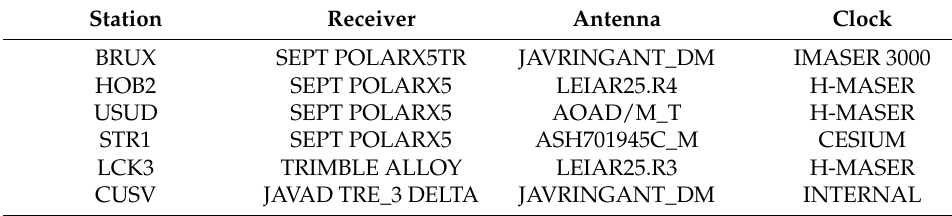
Figure 2. Location of the six stations. Table 1. Summary of the six stations.